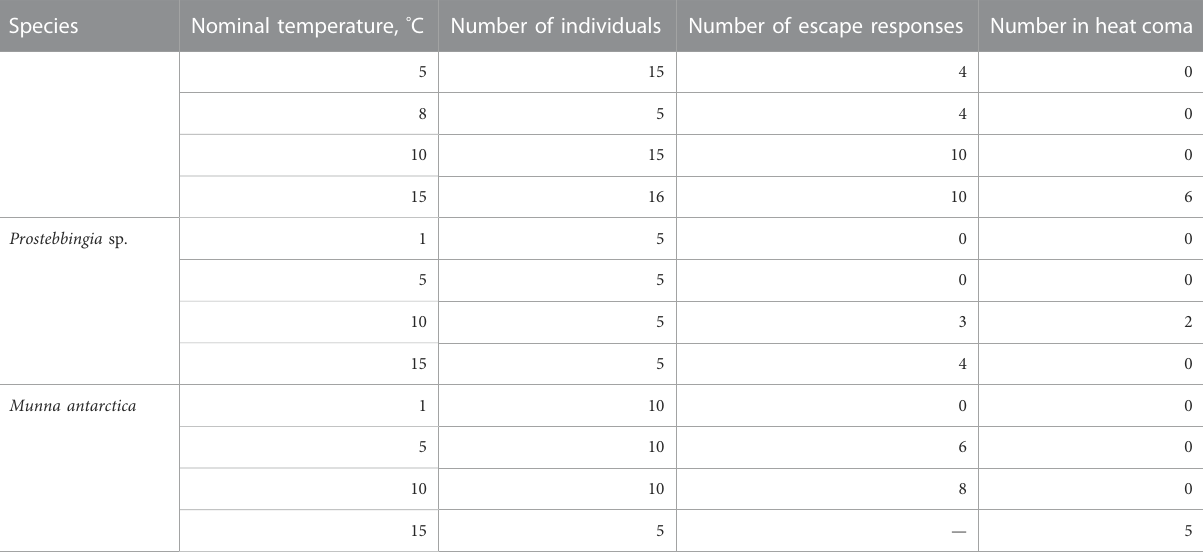
TABLE 2 Control and escape behaviours of 11 species of Antarctic marine invertebrates. Species Antarctonemertes spp.